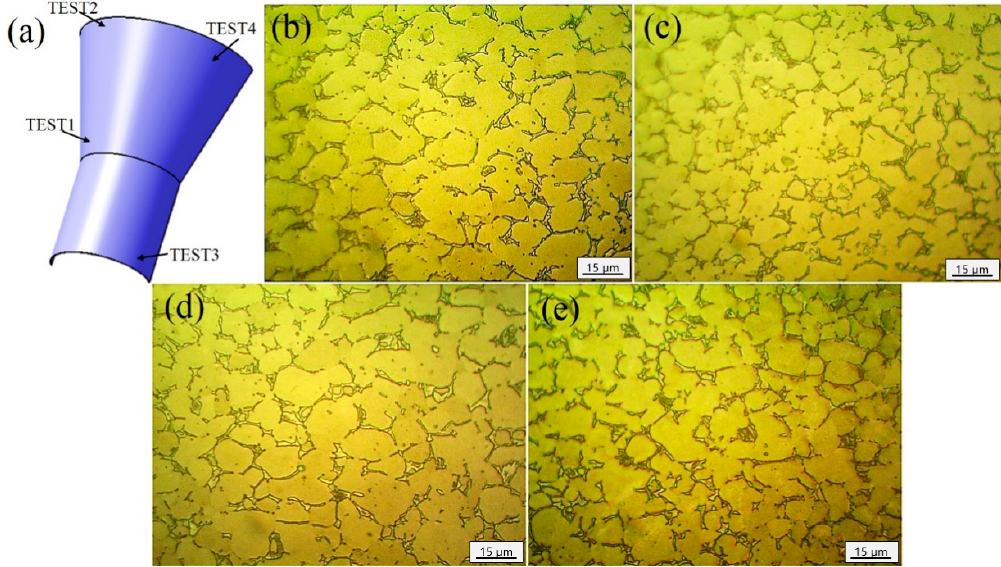
Figure 15. Microstructure images of Ti55 hot press formed workpiece at different locations: ( a ) The formed part; ( b ) TEST1; ( c ) TEST2; ( d ) TEST3; ( e ) TEST4.